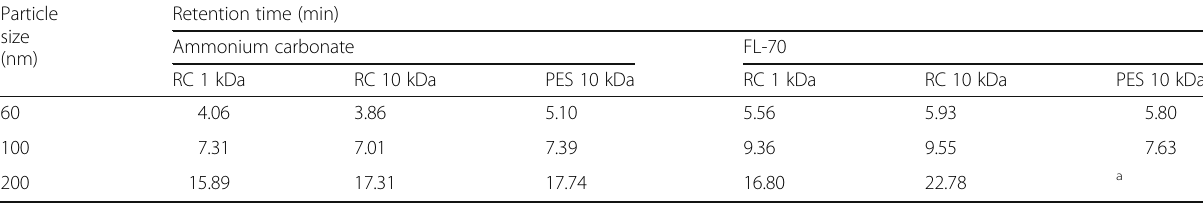
Table 3 Retention time of silica nanoparticles in various carrier solutions and membranes Particle size